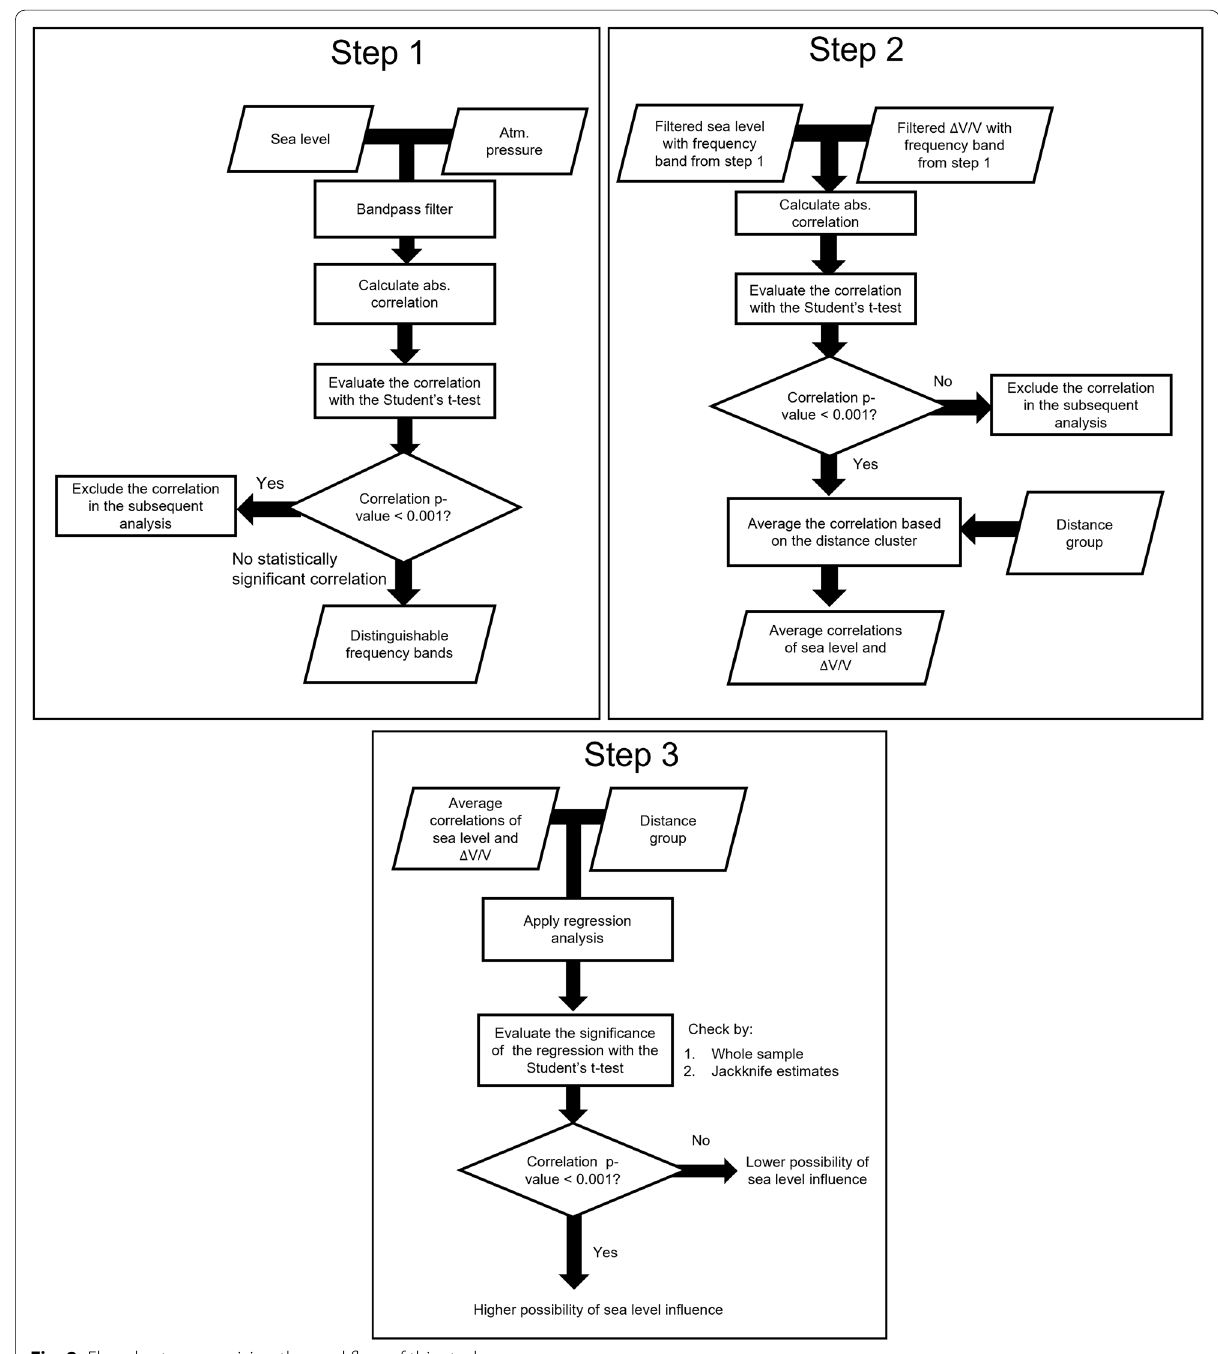
Fig. 2 Flowchart summarizing the workflow of this